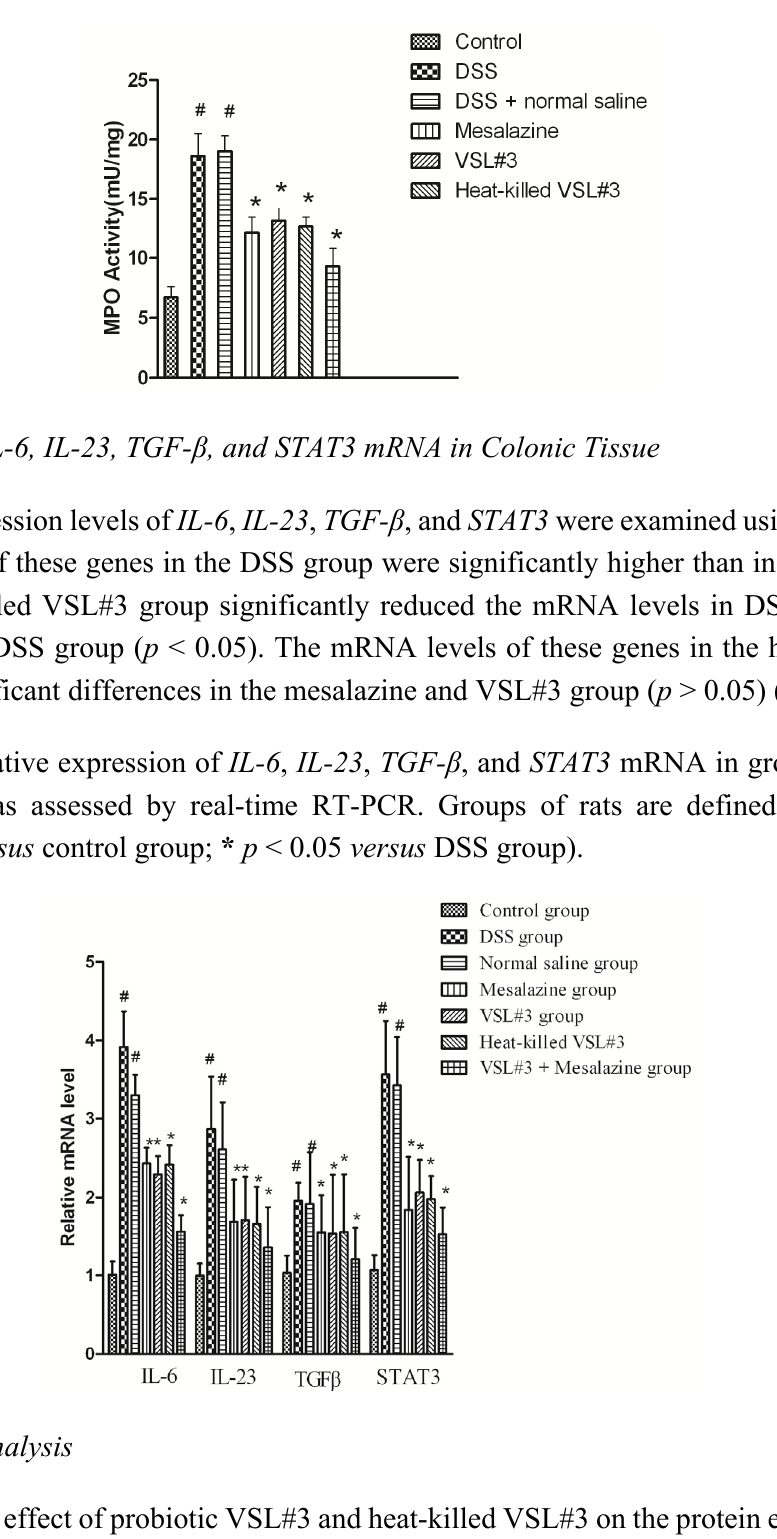
Figure 3. MPO activity of rats in each group ( # p < 0.05 versus control group; * p < 0.05 versus DSS group).